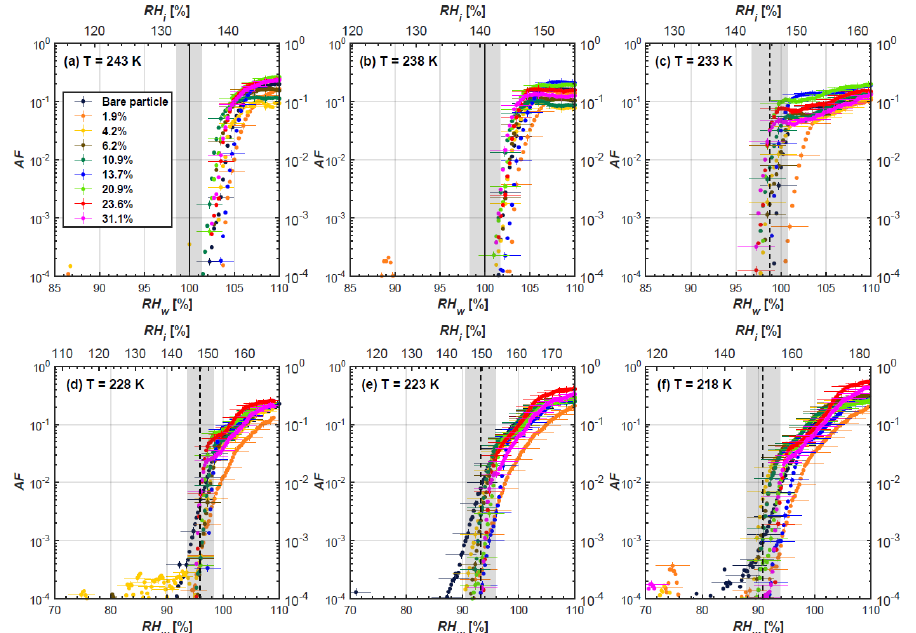
Figure B2. RH scans for bare and coated 400nm mCASTblack soot particles at eight different coating wt% corresponding to the 1µm OPC channel, presented as AF as a function of RH. Black solid lines represent water saturation conditions according to Murphy and Koop (2005). Black dashed lines denote the expected RH values for homogeneous freezing at T < HNT (Koop et al., 2000). The grey-shaded areas show the possible RH uncertainty calculated for water saturation and homogeneous freezing conditions. The percentage number represents the H 2 SO 4 coating mass ratio to the bare particle